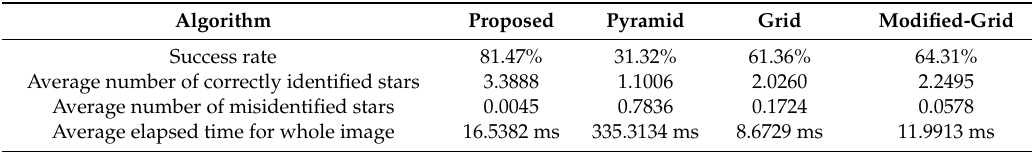
Table 8. Case 2: Comparing results of star identification methods at 150 arc-seconds position